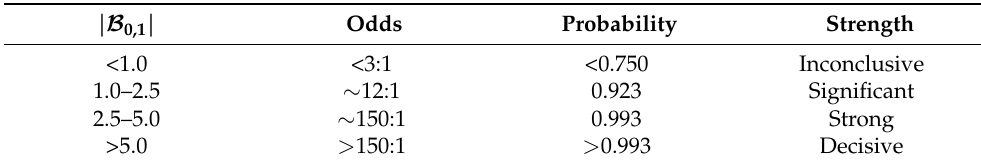
Table 2. Jeffreys guideline scale for evaluating the strength of evidence when two models are compared. |B 0,1 | Odds Probability Strength <1.0 <3:1 <0.750 Inconclusive 1.0–2.5 0.923 2.5–5.0 150:1 0.993 Strong ∼ >5.0 > 150:1 > 0.993